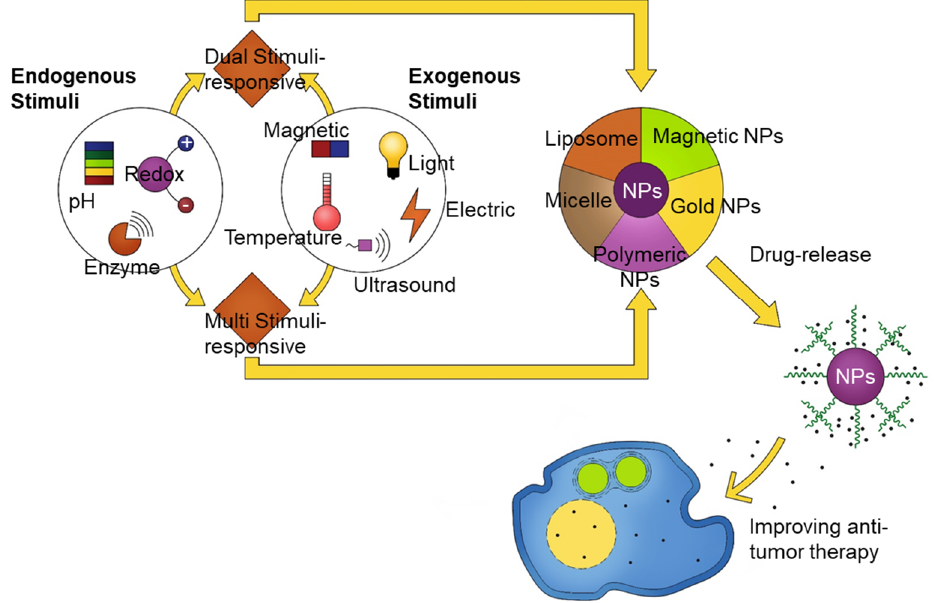
Figure 3. Scheme showing the future perspectives of combination stimuli-sensitivities and nanomaterials for biomedical applications.